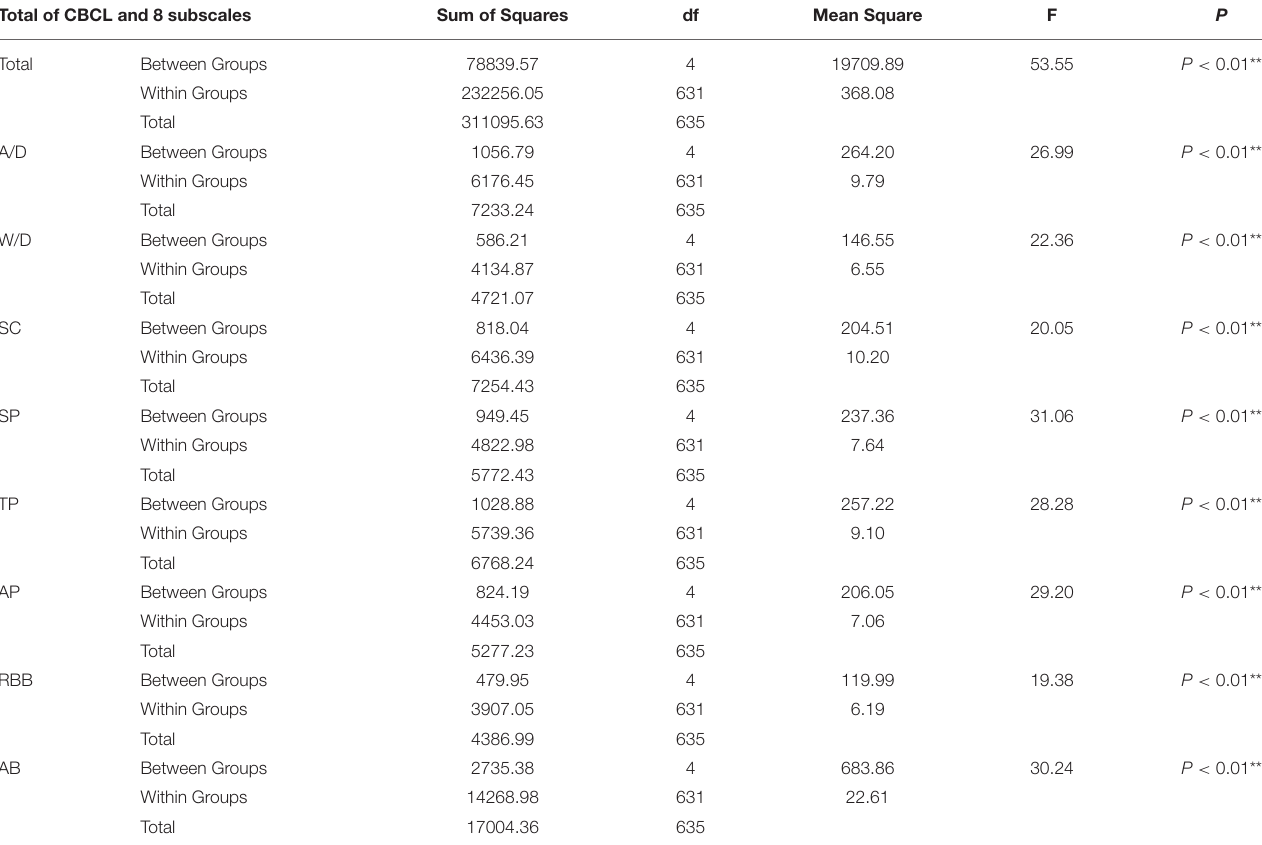
TABLE 3 | MANOVA analysis based on CBCL. Total of CBCL and 8